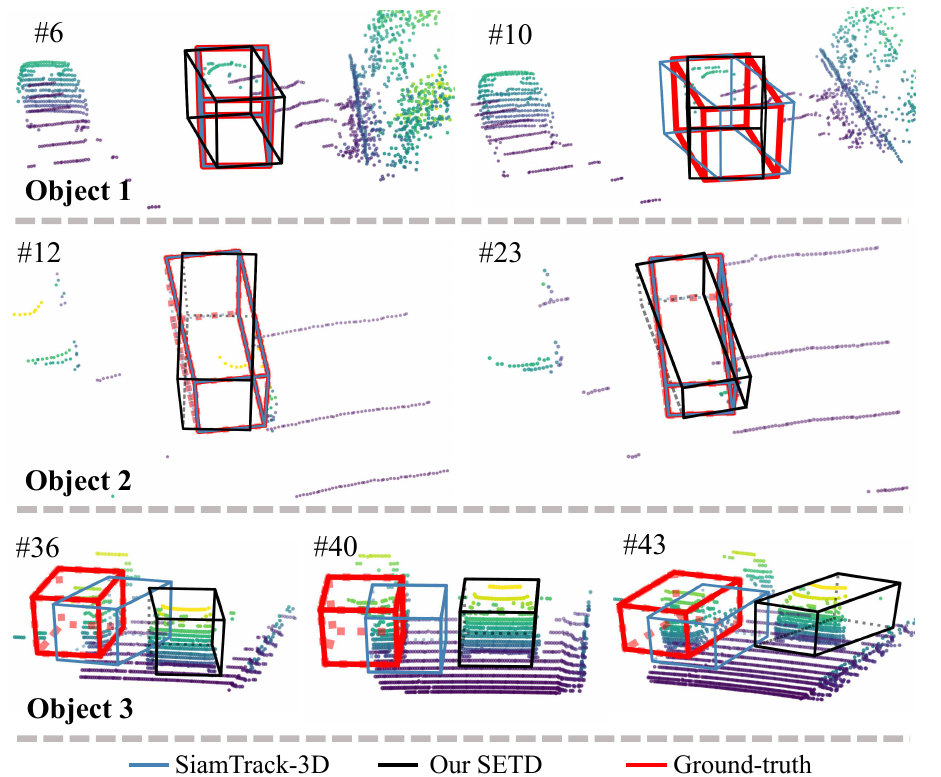
Figure 11. Failure cases of our proposed method. The first and second rows show failure to track the target due to extremely sparse point clouds. The last row shows failure due to similar distractors. The number after # is the frame